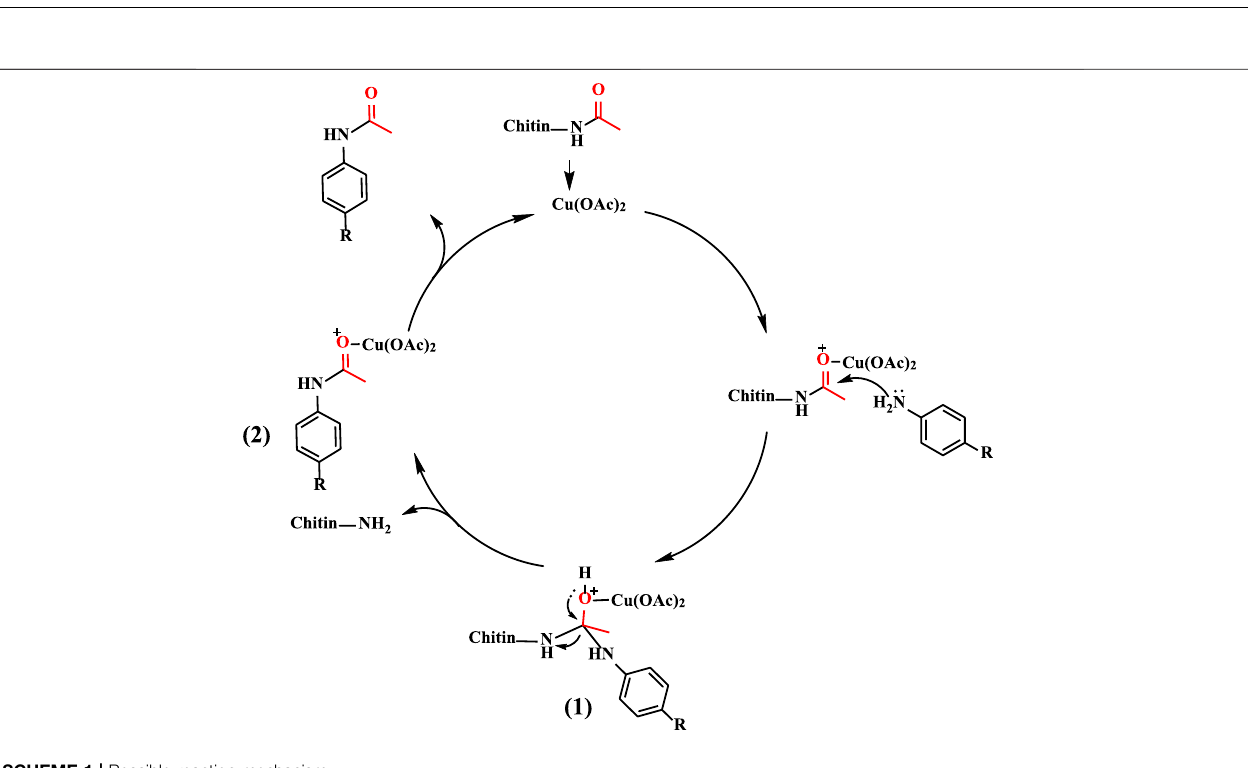
FIGURE 2 | The optimization of reaction factors. (A) solvents screening. (B) reaction time. (C) reaction temperature. (D) the amount of catalyst. Reaction conditions: chitin 0.1 g, aniline 0.1 ml, DMF 2.9 ml, catalyst 30 mg, 140 ° C, 12 h.